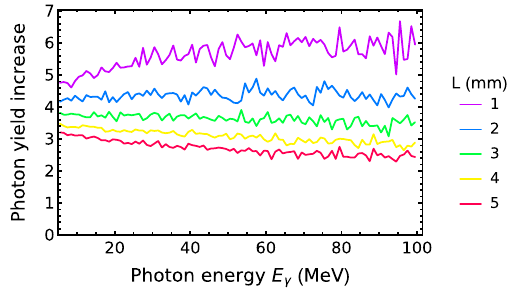
Fig. 9 Radiation enhancement in the tungsten (W) crystal aligned along (cid:2) 111 (cid:3) axes compared to the amorphous target having the same thickness (random orientation of the crystal). Electron beam energy is 6 GeV